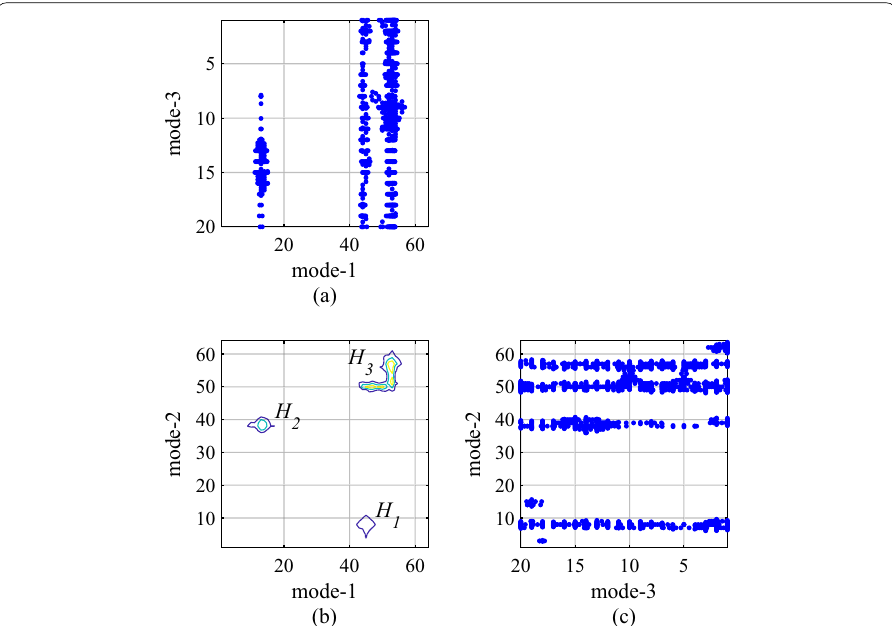
Fig. 6 Phase congruency in computed tensor M in Fig. 2. a , c Scatter plots along mode-3. b 3-level contour plot